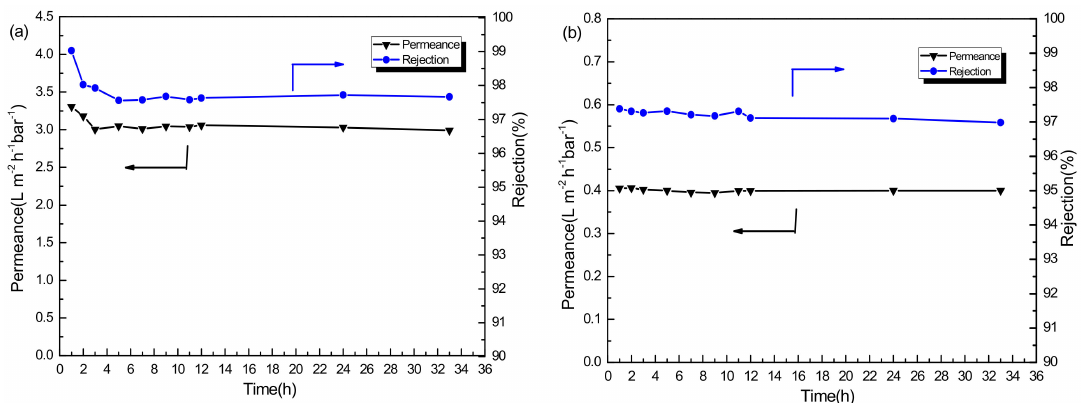
Figure 6. Long-time test of PSf/PA-SiO 2 0.025% membrane: ( a ) RB in methanol solution and ( b ) RB in ethanol solution.